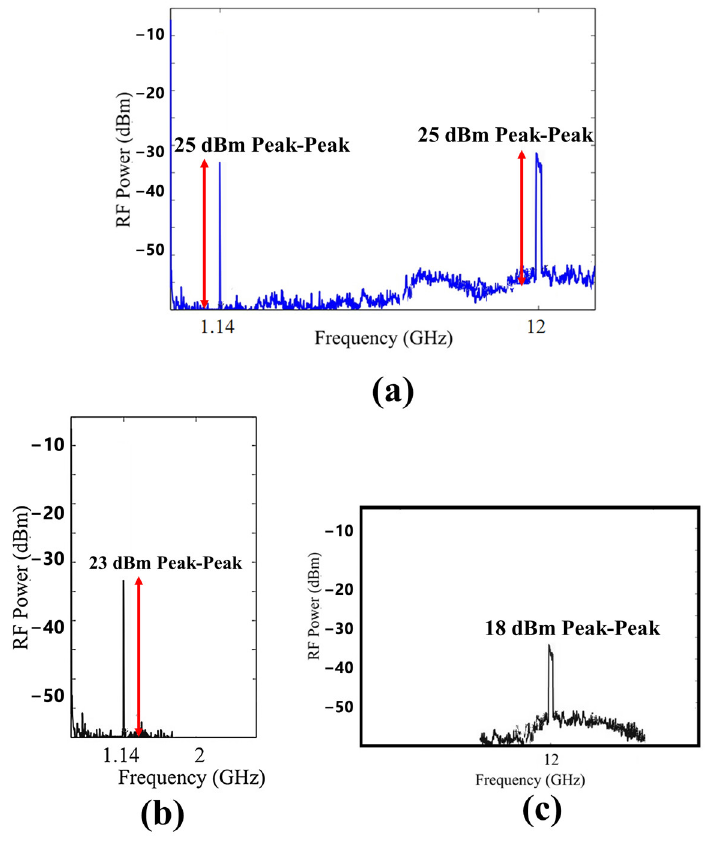
Figure 5. RF power vs. frequency showing ( a ) multiband signal of 5G after down conversion back to IF of 1.14 GHz and 6G signal at 12 GHz. ( b ) 5G signal at 5G RAU showing the received signal after 10 km of fibre length. ( c ) 6G signal at 6G RAU showing the received signal after 10 km of fibre length and 3 m wireless distance.